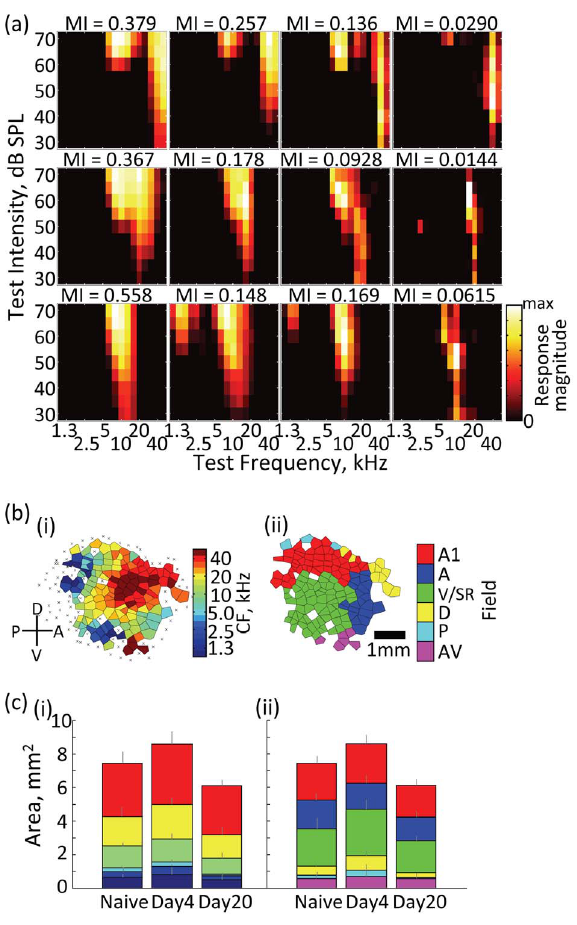
Figure 1. Characterization of neural responses in the auditory cortex. (a) Representative frequency response area (FRA). Mutual information (MI) for each unit is indicated in the upper of insets. (b) Representative functional map in the rat auditory cortex: (i) tonotopic map; and (ii) auditory field map. The primary, anterior, ventral/ suprarhinal, posterior, dorsal, and antero-ventral auditory fields are labeled as A1, A, V/SR, P, D, and AV, respectively. (c) Learning-stage- dependent representational area. Functional maps were quantified in the naı¨ve group (n=8) and conditioned groups at the early (day 4; n=8) and late stages (day 20; n=8). The conditioning groups were rewarded by nose-poking at the presentation of 20-kHz